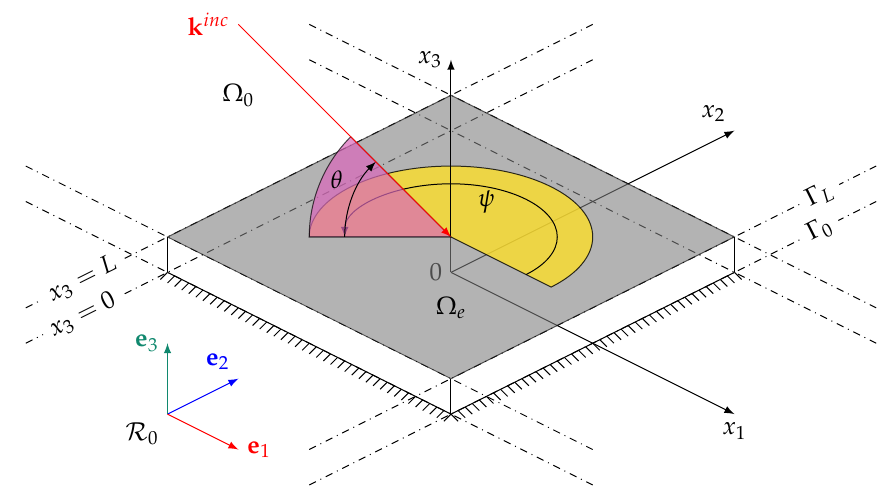
Figure 1. (Color online) Schematic of the propagation problem. The incident wave-vector k inc has azimuth and elevation angles ψ (yellow) and θ (light purple)